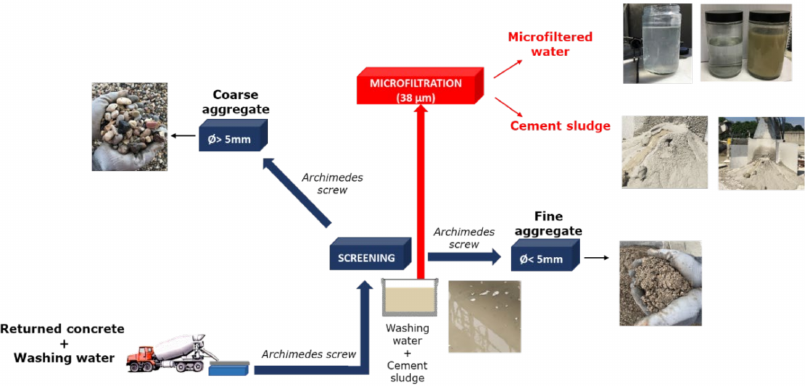
Figure 3. Proposed returned concrete treatment process. Section dedicated to the recovery of fine and coarse aggregates (blue zone) and section dedicated to the treatment of washing water to obtain microfiltered water and cement mud (red zone).